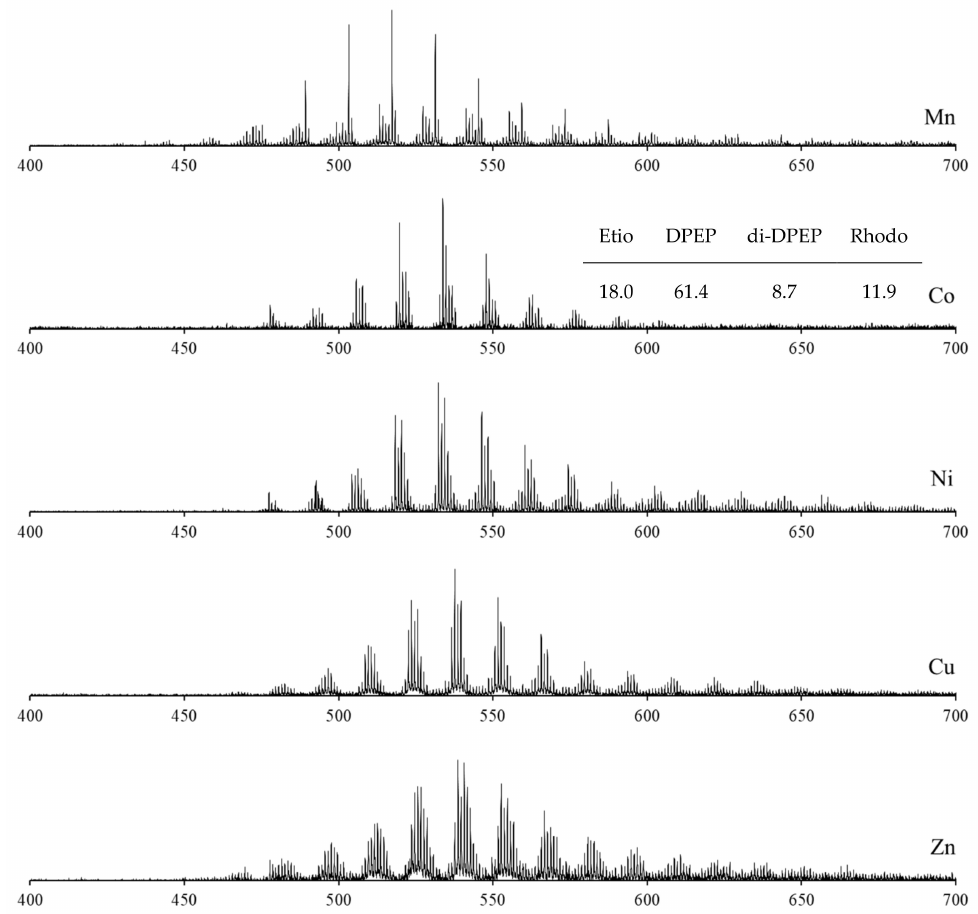
Figure 4. MALDI-TOF mass spectra of petroleum metalloporphyrin complexes synthesized in the present